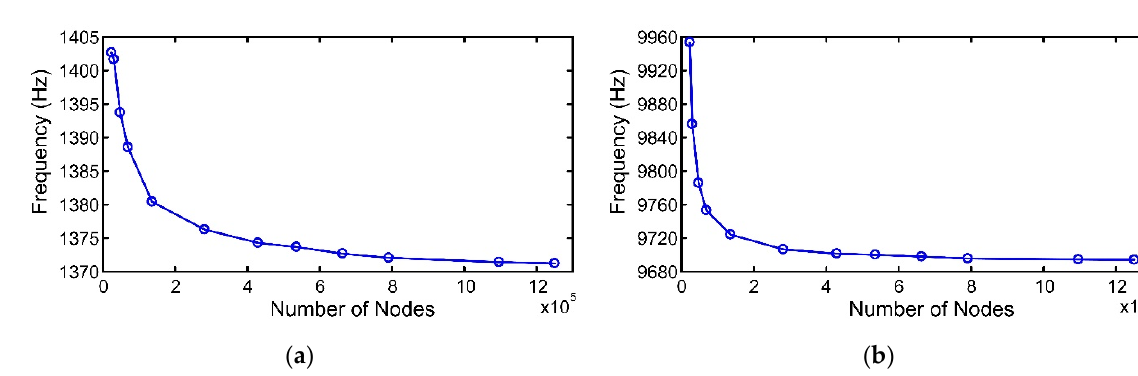
Figure 9. Frequency convergence history: ( a ) 2ND mode; ( b ) 1T mode.